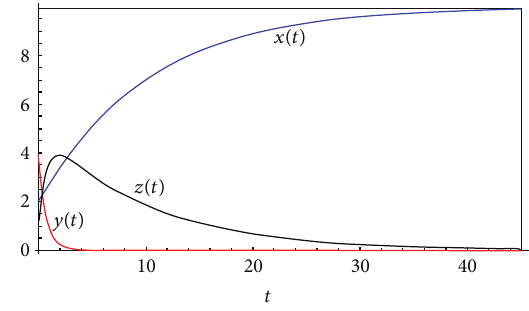
Figure 2: 𝑅 0 < 1 ; rumor “dies